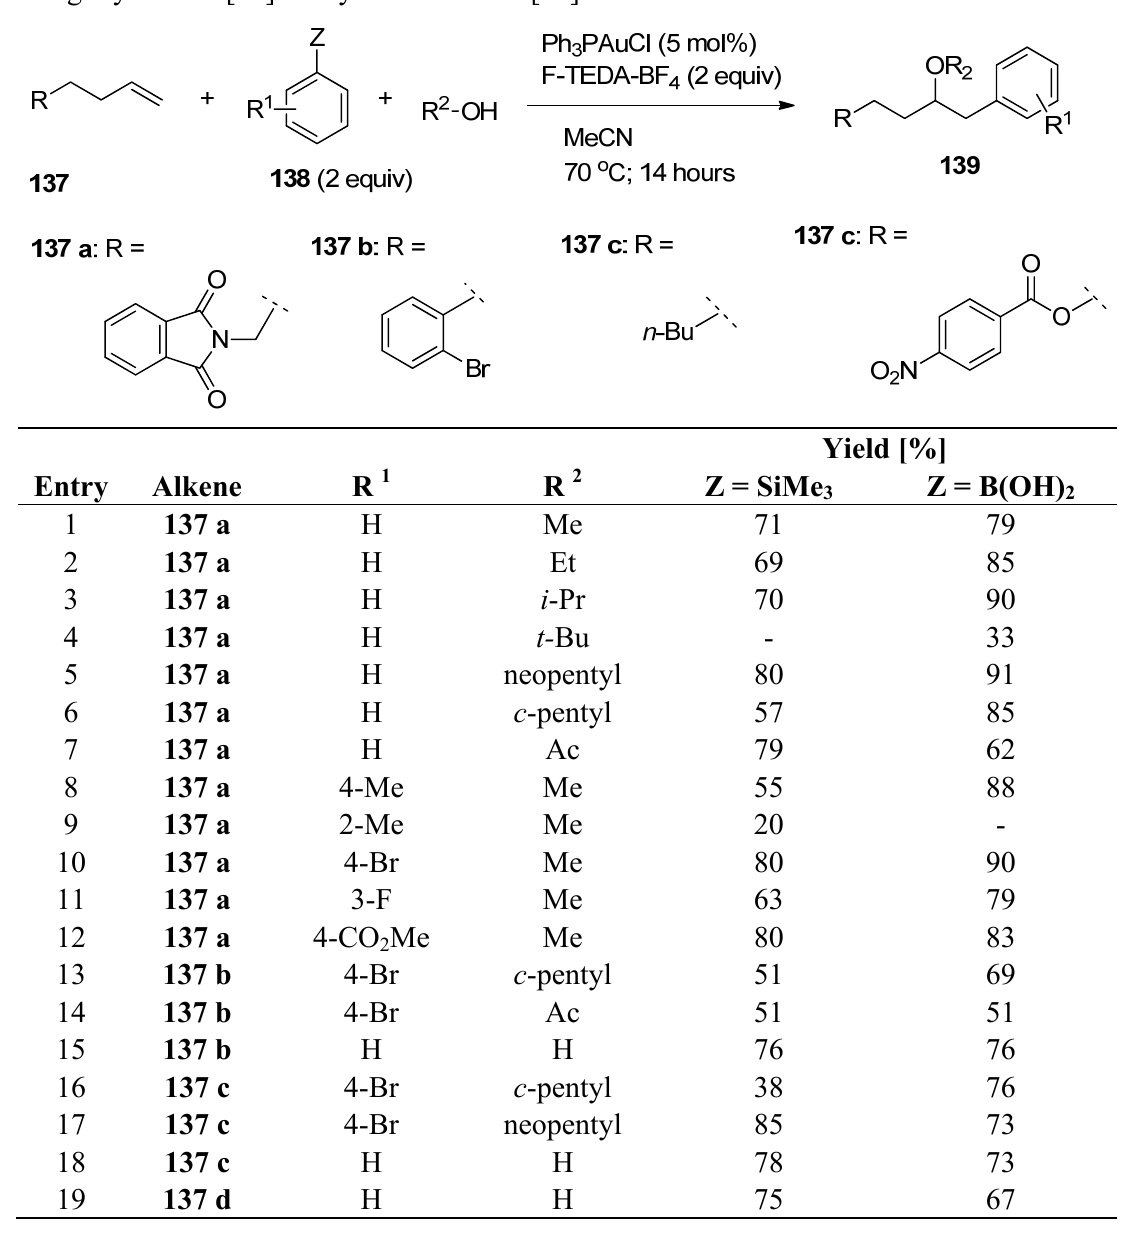
mediated oxyarylation of terminal alkenes 4